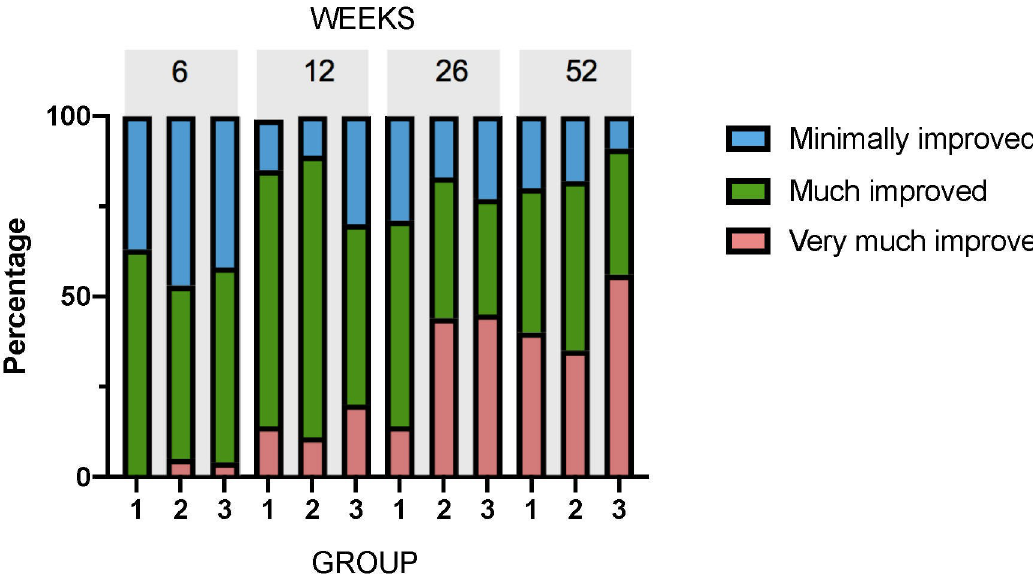
Fig 3. Comparison of global rating of change (GROC) over time. 1 = very much improved, 2 = much improved, 3 = minimally improved. Group 1—exercise only, Group 2—sham IMS, Group 3—IMS. Not shown on graph: one participant in Group 3 was unchanged (GROC = 4) at 26 weeks, and one participant in Group 4 was minimally worse (GROC = 5) at 52